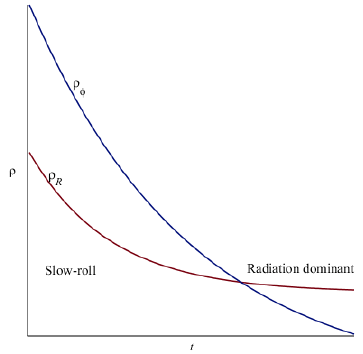
Figure 4 . During slow-roll warm in(cid:13)ation the radiation energy density is comparable with the scalar (cid:12)eld energy density but smaller than it. At the end of the slow-roll part the radiation energy density smoothly dominates on the in(cid:13)aton energy